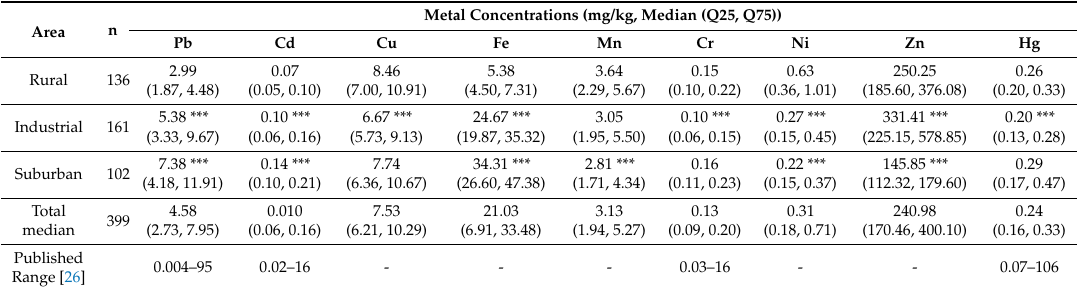
Table 8. Metal concentrations in student scalp hair in the rural, industrial and suburban areas.